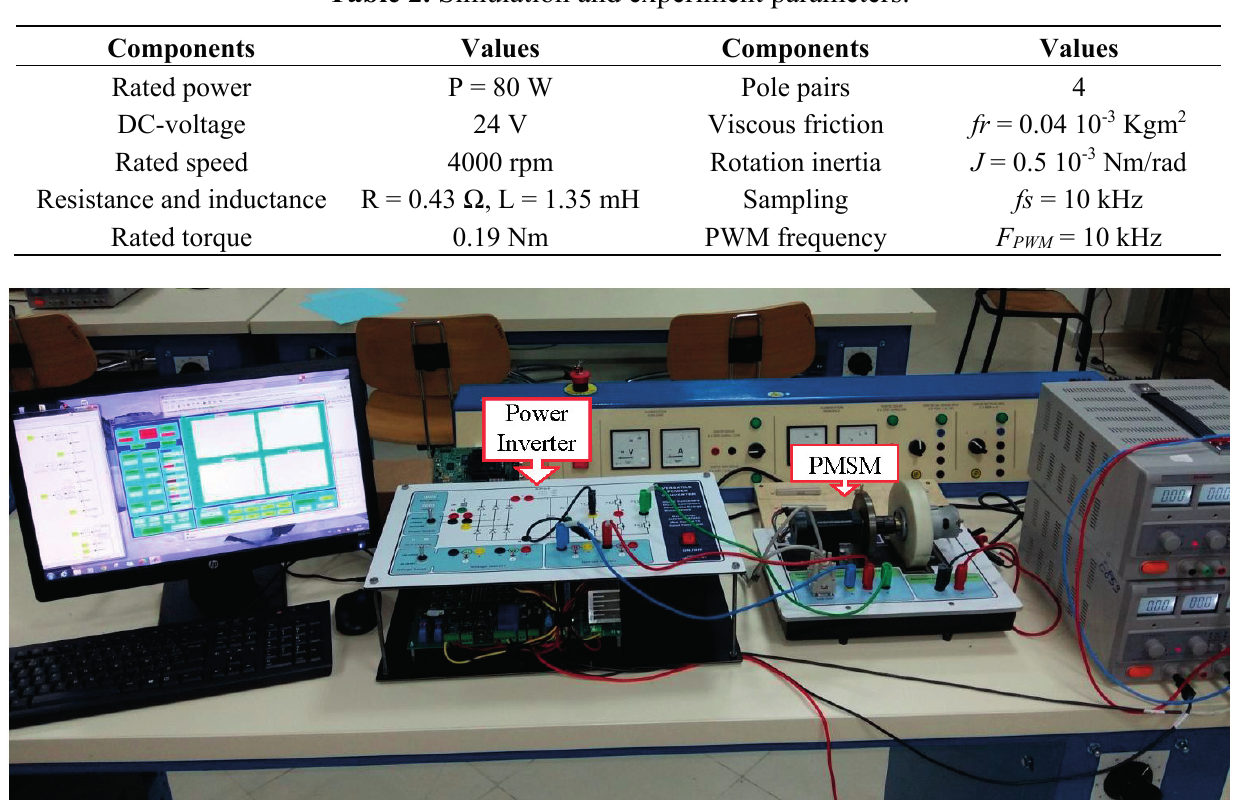
Table 2. Simulation and experiment parameters.